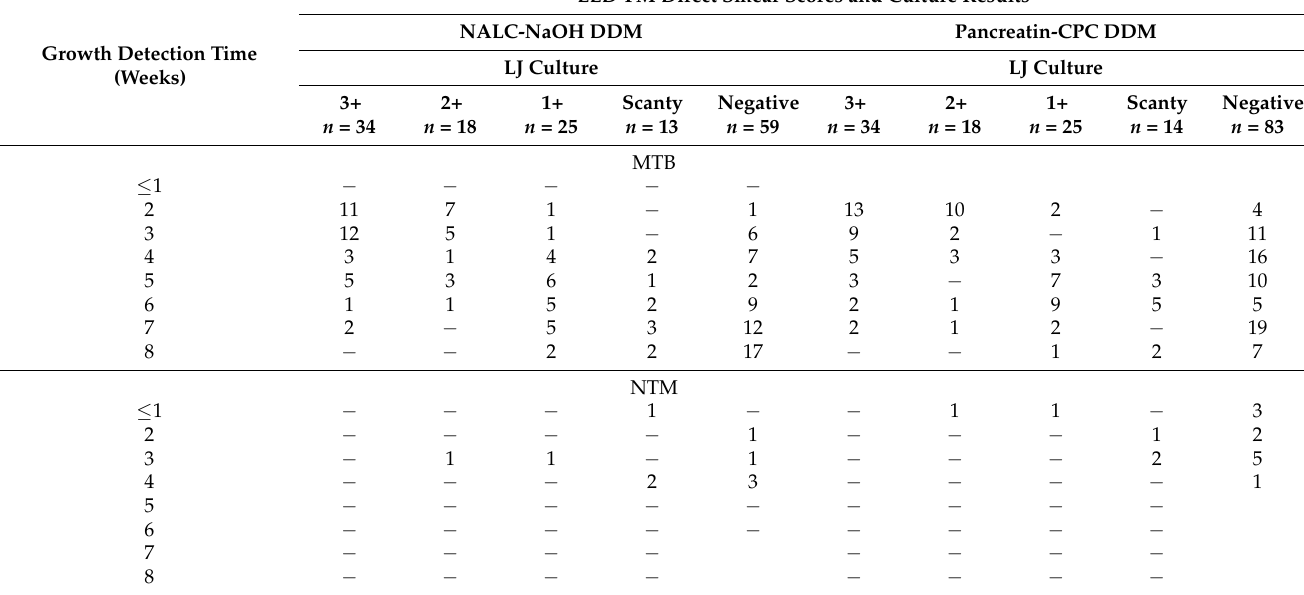
Table 4. Growth detection time of LJ culture for recovery of Mycobacterium tuberculosis (MTB) and non-tuberculous Mycobacteria (NTM) after digestion and decontamination with NALC-NaOH and pancreatin-CPC DDM as indicated by LED-FM smear scores.